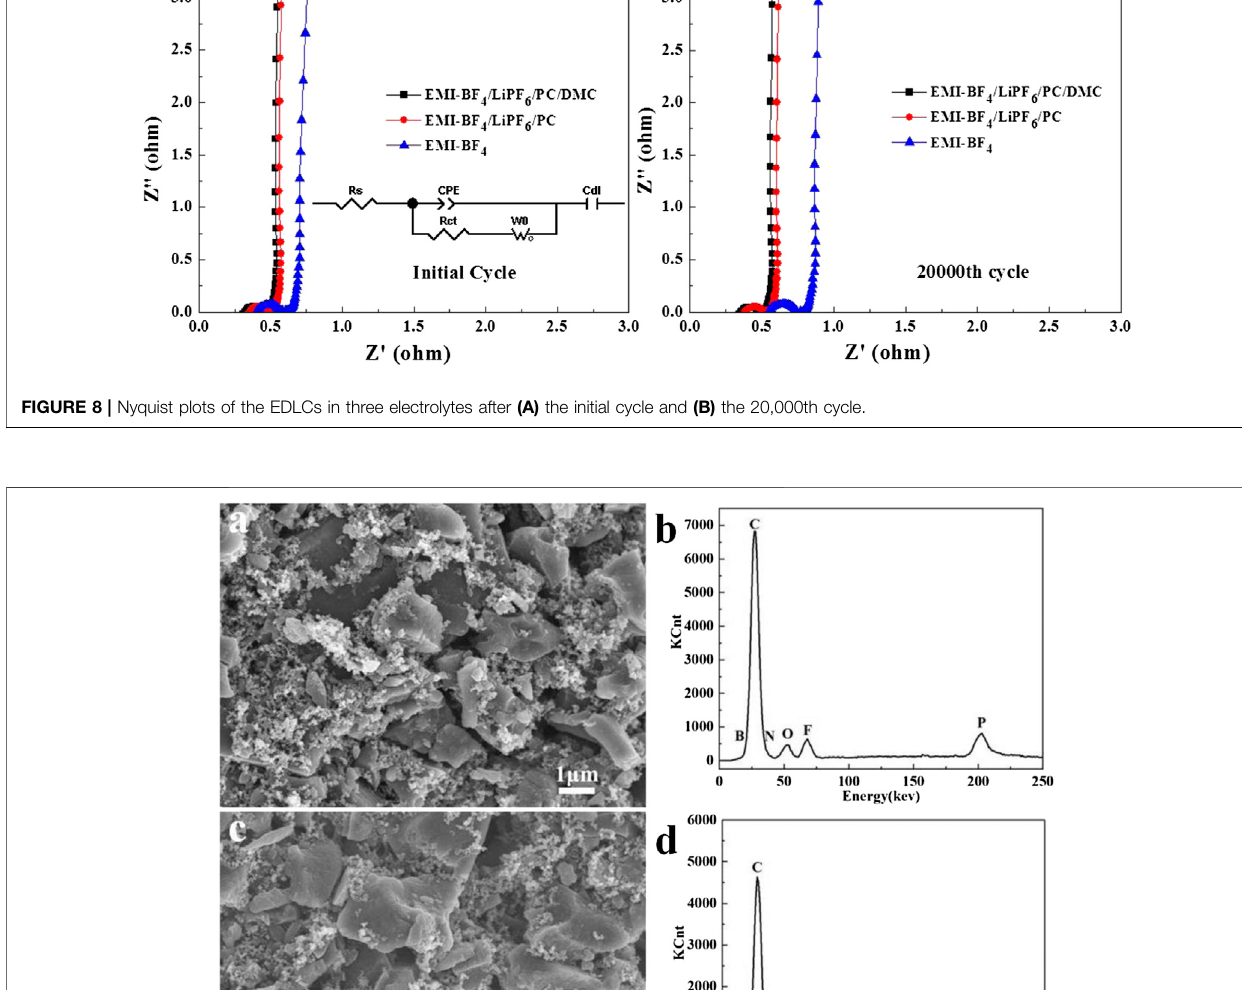
Frontiers in Materials |